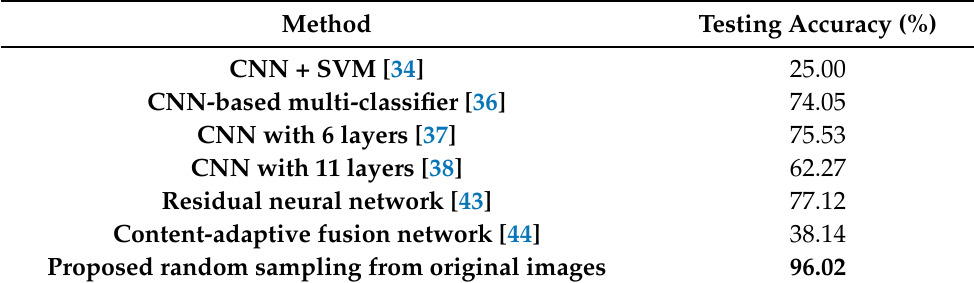
Table 6. Performance comparison of proposed methods with state-of-the-art techniques on UNISA2020